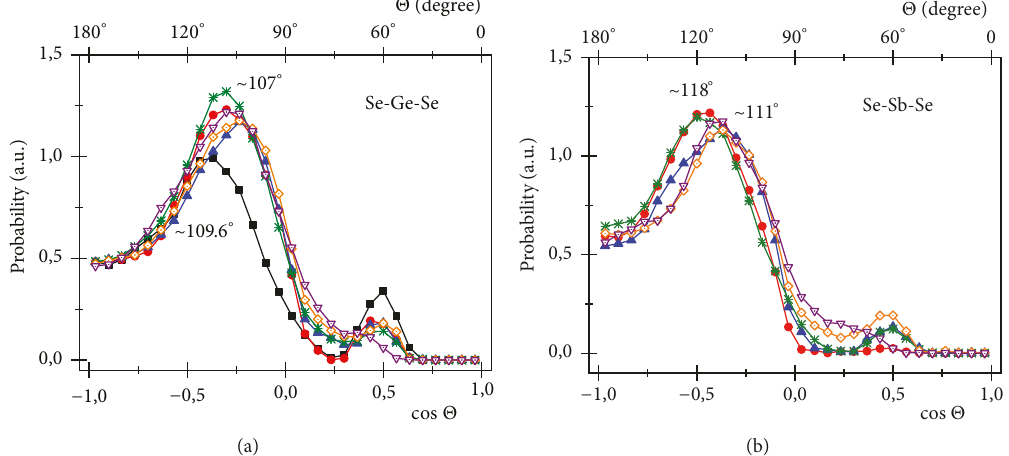
Figure 5: Bond-angle distributions of Se-Ge-Se (a) and Se-Sb-Se (b) configurations for the corresponding compositions of Ge 40 Se 60 (black square), Ge 35 Sb 5 Se 60 (red circle), Ge 32 Sb 8 Se 60 (blue triangle), Ge 27 Sb 13 Se 60 (green crosses), Ge 20 Sb 20 Se 60 (orange square), and Ge 15 Sb 25 Se 60 (purple reverse